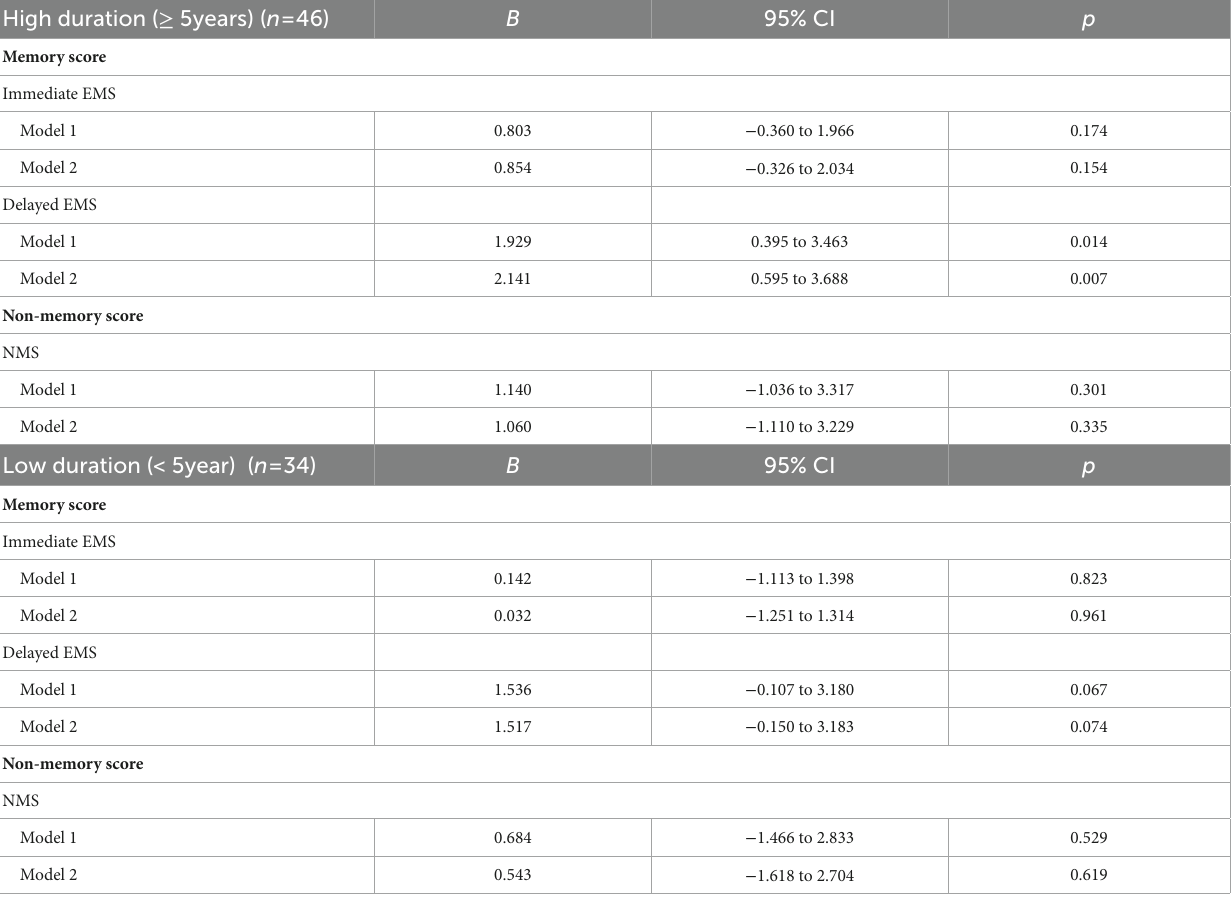
TABLE 5 Results of the multiple linear regression analyses of the association between ginseng intake status (high duration vs. low duration) and cognition. High duration ( ≥ 5 years) ( n =